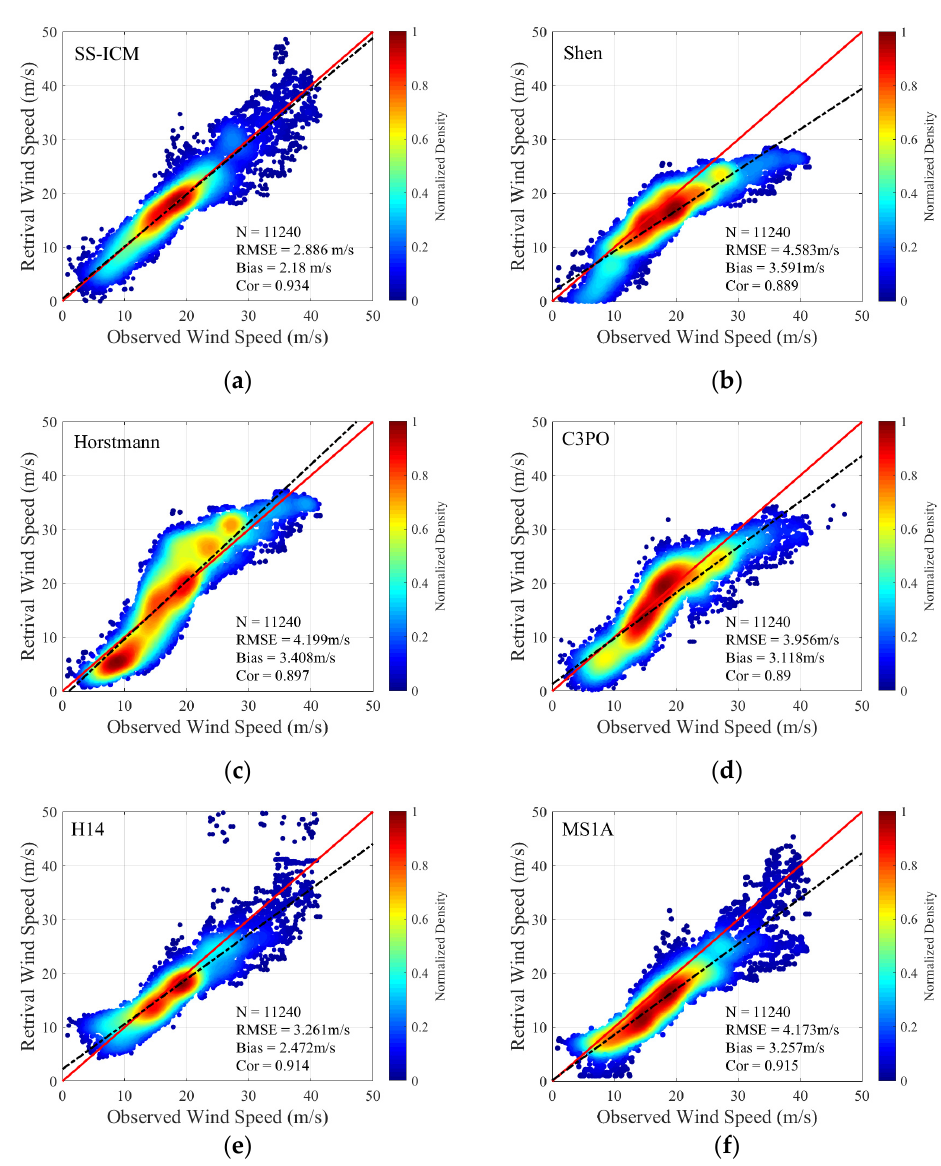
Figure 12. The retrieved wind speeds with ( a ) SS-ICM model; ( b ) Shen model; ( c ) Horstmann model; ( d ) C3PO model; ( e ) H14 model; ( f ) MS1A model in dataset A vs. the ‘real’ wind speeds. Table 4. The RMSE and bias of the retrieved wind speeds based on different GMFs.